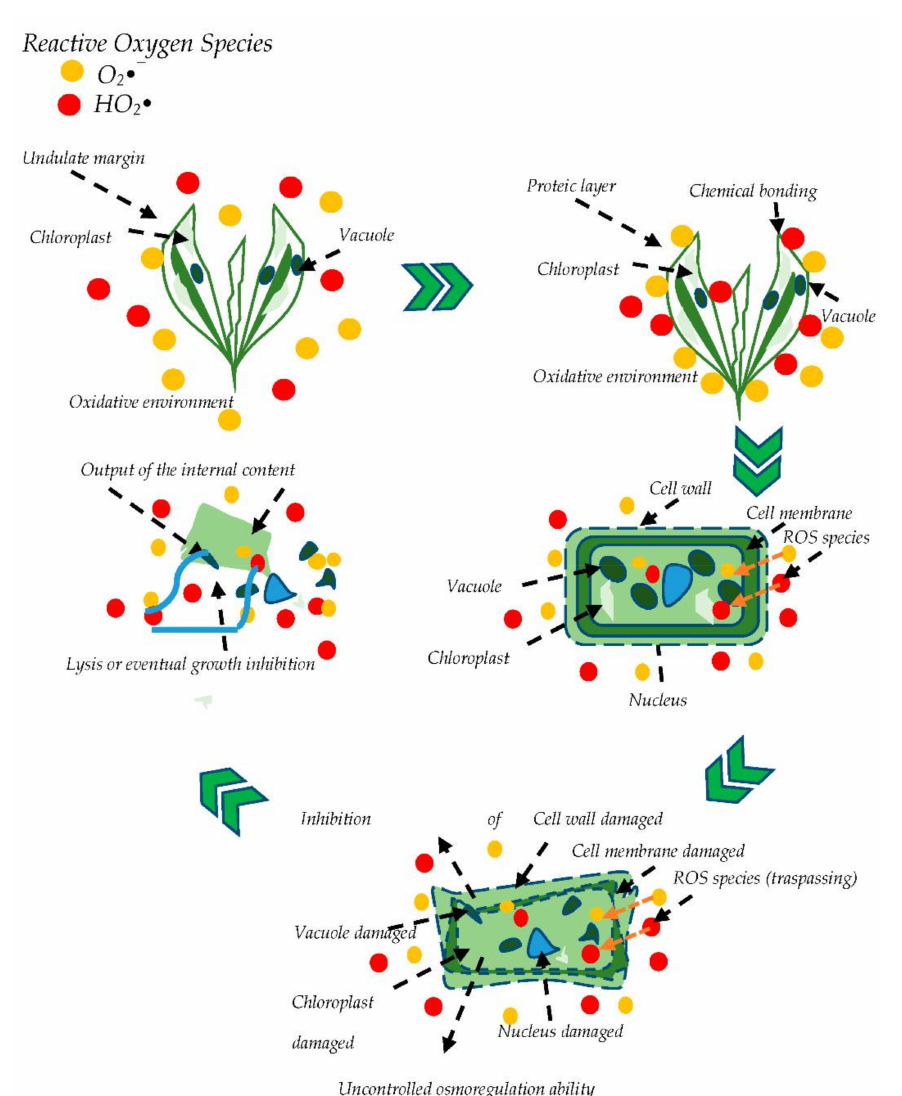
Figure 3. Disinfection mechanism purposed for Algae using TiO 2